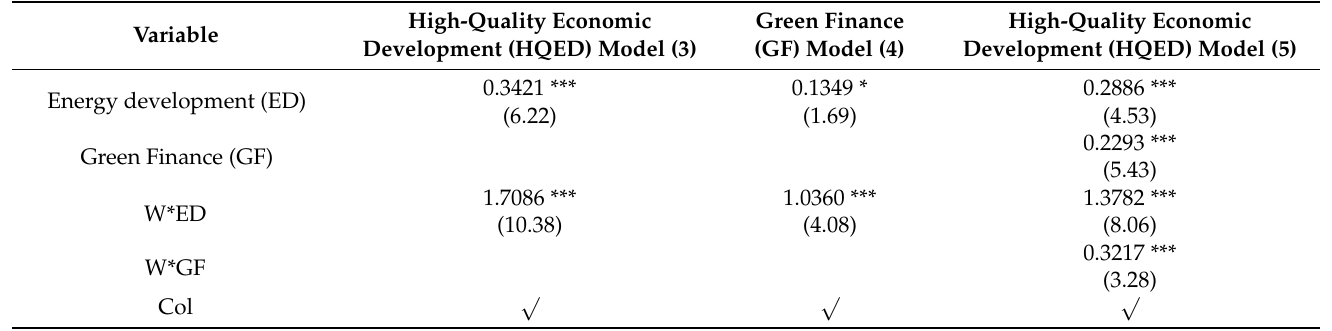
Table 7. Test results of the intermediary effect of green